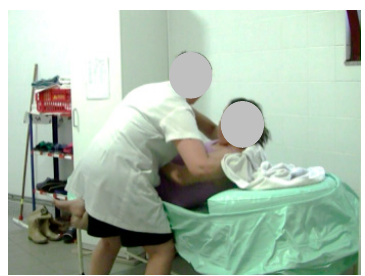
Figure 11. Step 21: The layer is removed.